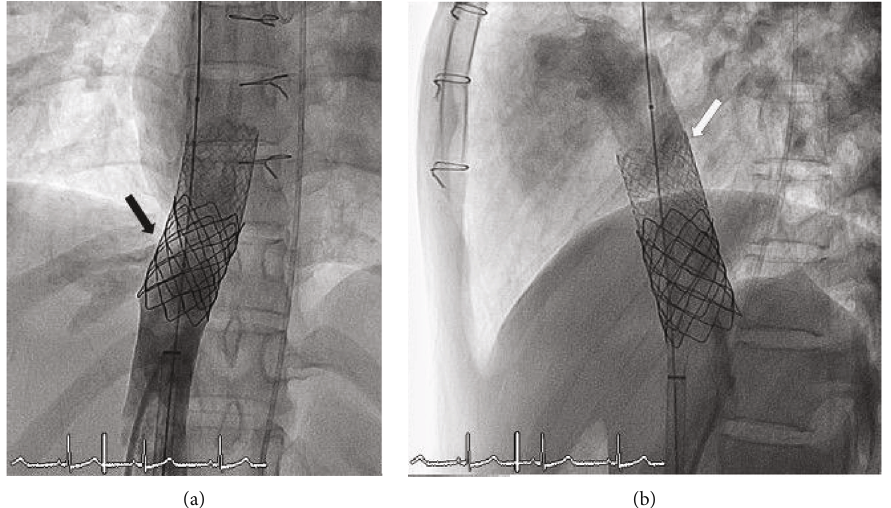
Figure 11: The covered stent (white arrow), which was placed second, is positioned superior to the anchored bare stent (black arrow) in the inferior vena cava ((a) anteroposterior and (b) lateral views on angiography). The placement of covered stent was supposed to be above the entrance of the right lower pulmonary vein (RLPV) but at the expense of overlapping segment because the bare stent was placed lower enough into the IVC. This can be compared with fi nal position of the covered stent after repositioning almost covering the entrance of RLPV but lower than the fi rst position (Figure 15). The stitch can be used as a guide